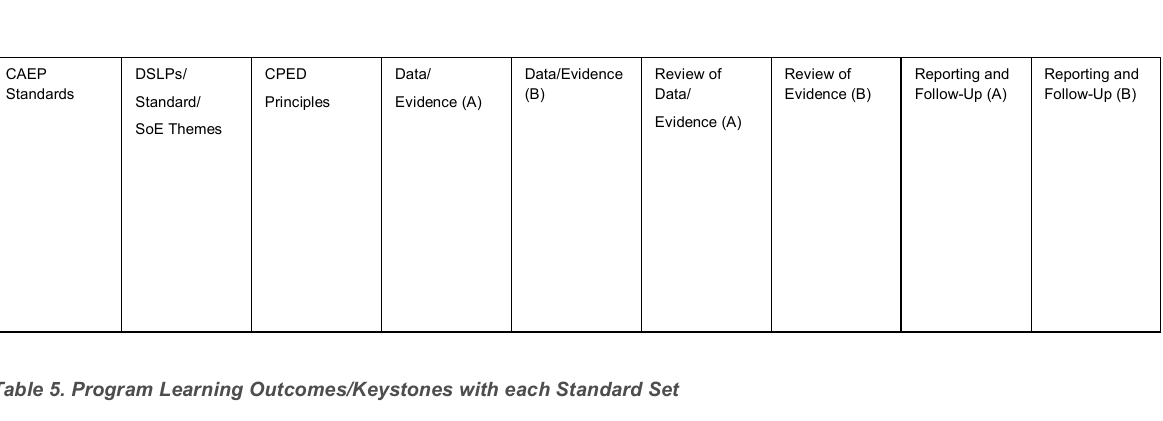
Table 4. Master Matrix with all Options